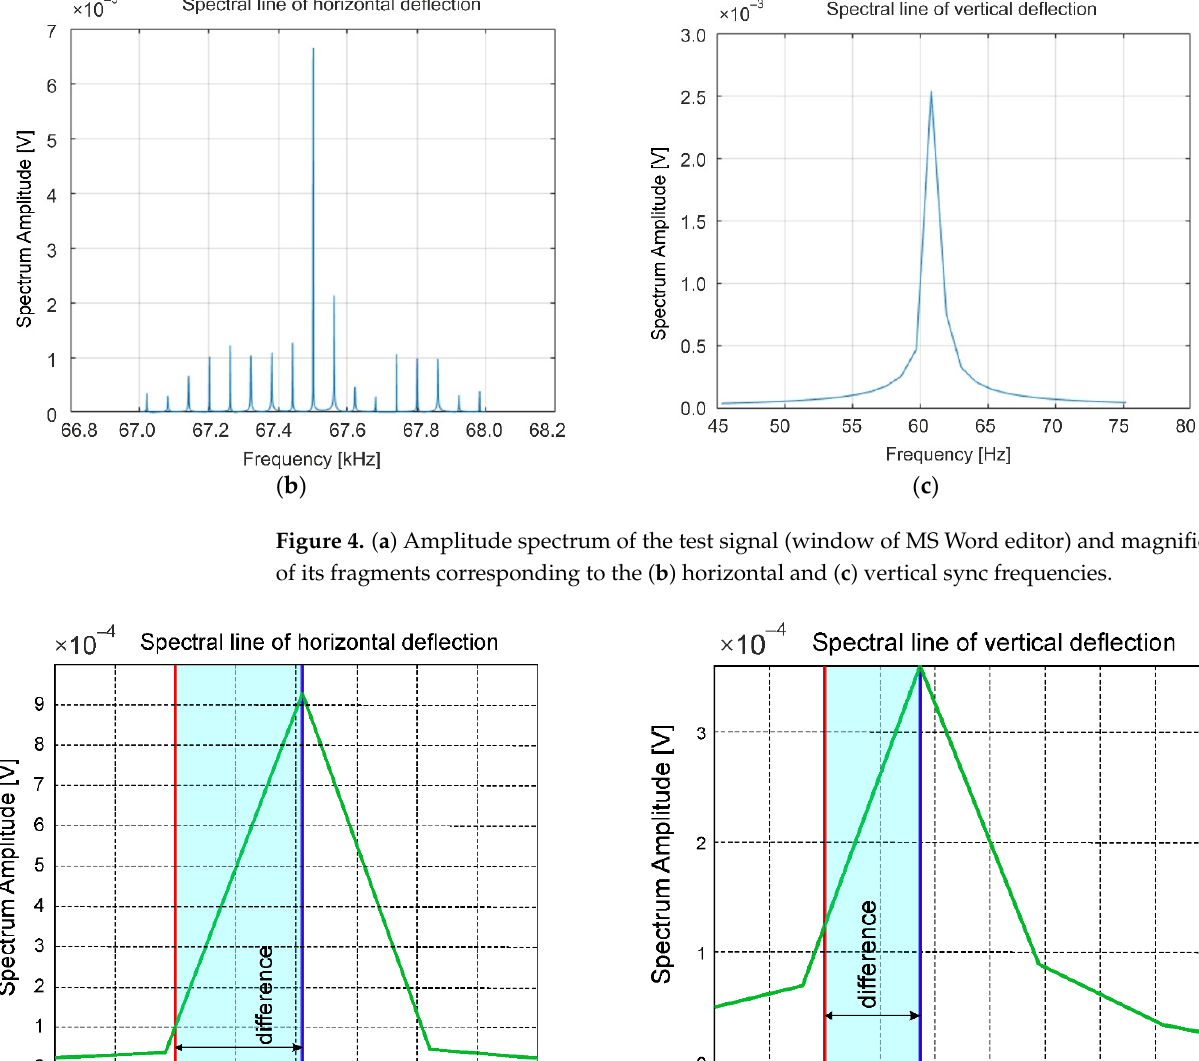
Figure 5. Magnification of the fragments of the amplitude spectrum corresponding to the ( a ) hori- zontal and ( b ) vertical sync frequencies.